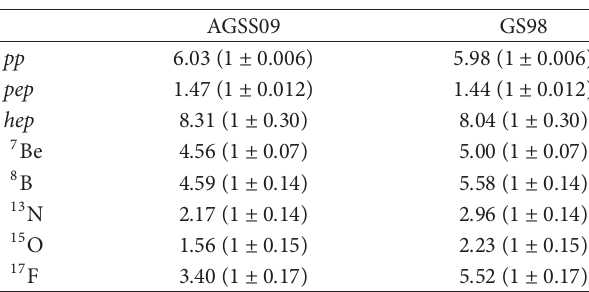
Table 2: The predictions of SSMs implementing GS98 [29] and AGSS09 [30] admixtures. See [15] for